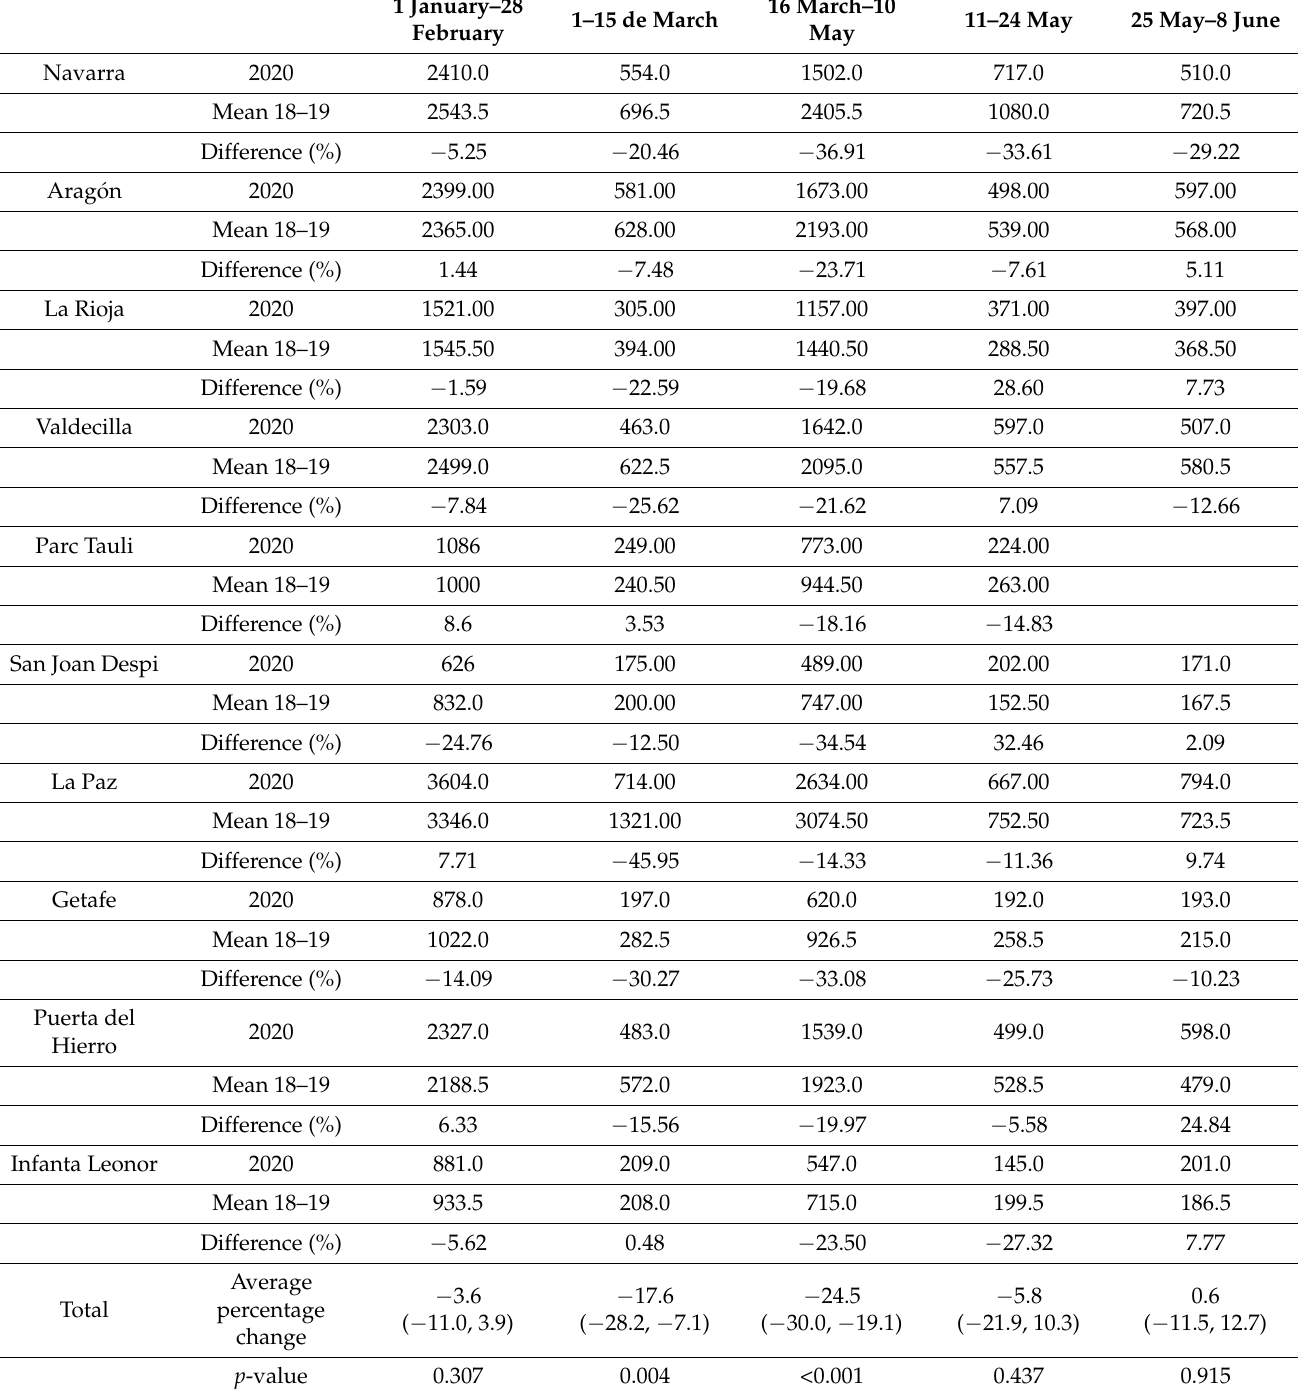
Table 4. Changes in the consumption of concentrated red blood cells by